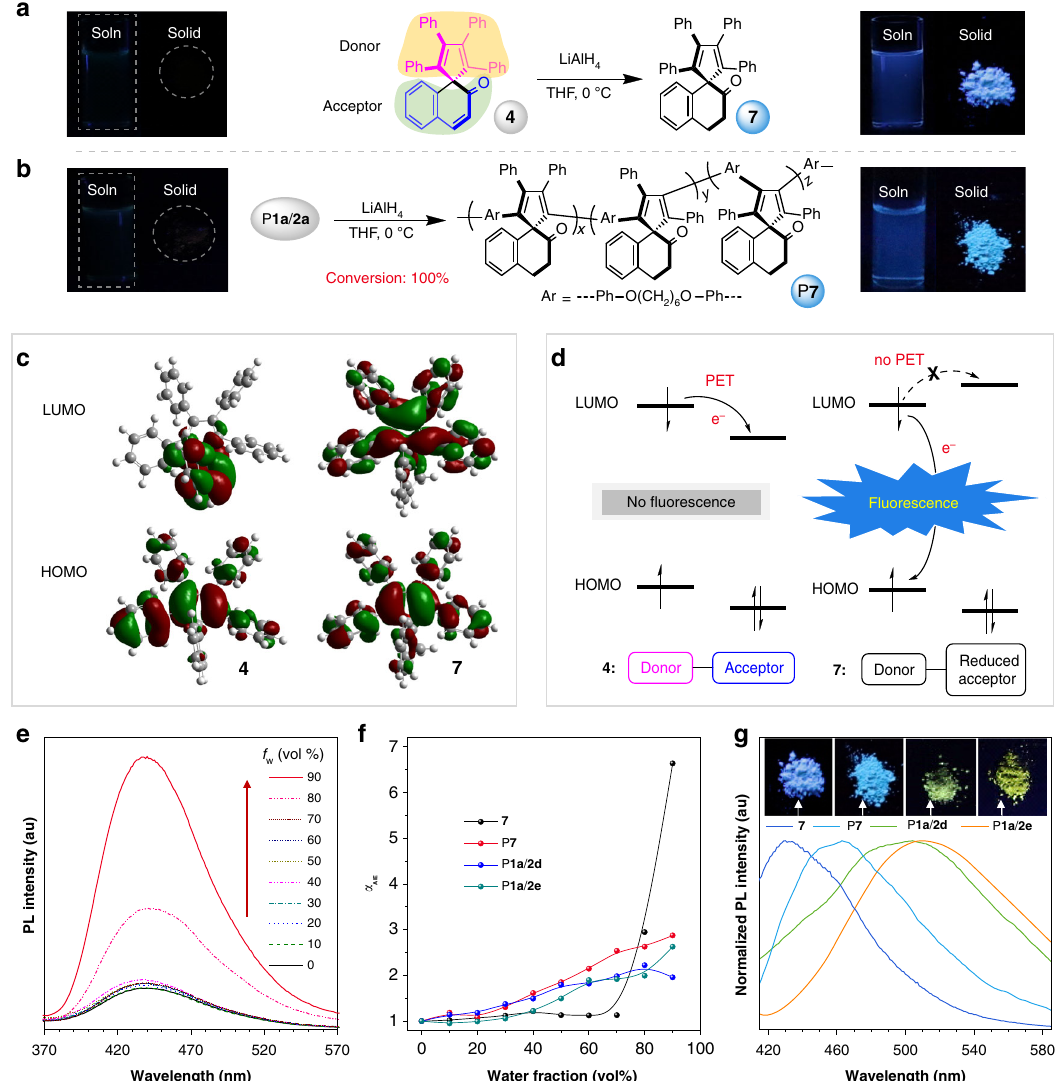
Fig. 4 Photophysical properties of model compounds and polymers. a Reduction of model compound 4 . b Reduction of P 1a / 2a . Inset: fl uorescent photographs of THF solutions and powder of 4 and P 1a / 2a (left side) and 7 and P 7 (right side). c Molecular orbitals of 4 and 7 in the ground state calculated by B3LYP/6-31G(d,p). d Schematic illustration of the modulation of fl uorescence properties by the photoinduced electron transfer (PET) process. e Photoluminescence (PL) spectra of 7 in THF and THF/water mixtures with different water fractions ( f w ). f Plot of the relative PL intensity ( I/I 0 ) versus the composition of the aqueous mixtures of 7 , P 7 , P 1a / 2d , and P 1a / 2e . α AIE = I / I 0 , where I 0 = intensity at f w = 0%. Solution concentration: 10 μ M. g Normalized PL spectra of the powder of 7 , P 7 , P 1a / 2d , and P 1a / 2e and their associated fl uorescent photographs. Excitation wavelength: 320 nm (for 7 and P 7 ); 350 nm (for P 1a / 2d and P 1a / 2e ). All fl uorescent photographs were taken under UV irradiation at 365 Fig. 4c suggest that 4 possesses a donor – acceptor structure. The highest occupied molecular orbital (HOMO) of 4 is primarily an aggregation-enhanced emission (AEE) property (Fig. 4e, f and localized on the TPC moiety, while its lowest unoccupied mole- cular orbital (LUMO) is mainly concentrated on the naphthalen- 2(1 H )-one part. In contrast, the electron cloud distribution of the HOMO and LUMO of the reduced product ( 7 ) is similar, indi- cative of the absence of donor – acceptor structure. Figure 4d provides a schematic illustration of the possible PET process. In model compound 4 , the excited electron is easily transferred from donor to acceptor, which hinders the return of electron to the HOMO of the donor and thus leads to fl uorescence quenching 39 . After the reduction reaction, the HOMO of the reduced acceptor locates at a higher energy level than that of the donor to block the PET process. Therefore, the excited electron is allowed to undergo radiative decay to result in strong fl uorescence in 7 and P 7 .